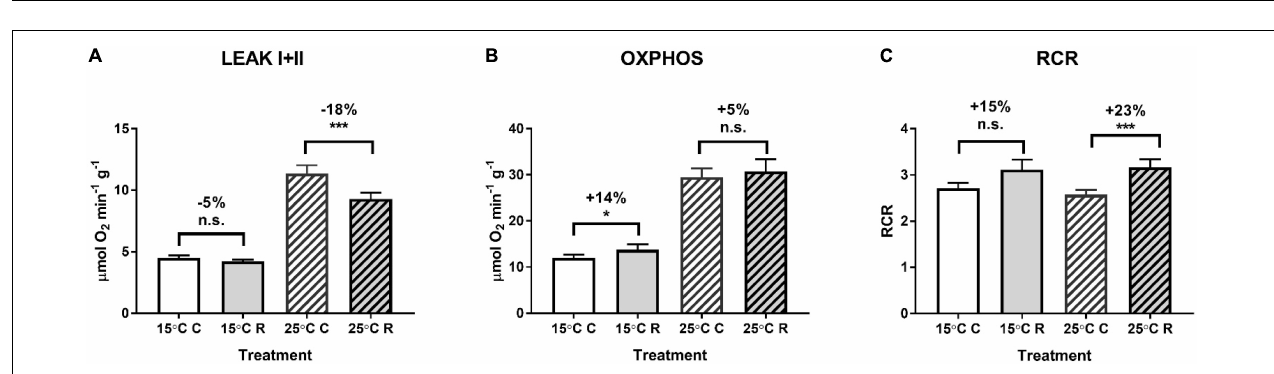
FIGURE 2 | Effects of hypoxia and reoxygenation (H/R) on respiration of isolated digestive gland mitochondria of M. edulis at different temperatures (15 or 25 ◦ C). (A) LEAK respiration, (B) OXPHOS respiration, and (C) respiratory control ratios. The percentage change following H/R stress was calculated by standardizing the control values at the respective temperatures to 100%. Significant differences in each mitochondrial trait between normoxia (C) and reoxygenation (R) are denoted by asterisks (* P < 0.05, *** P < 0.001). n.s. indicates differences that were not statistically significant ( P > 0.05).